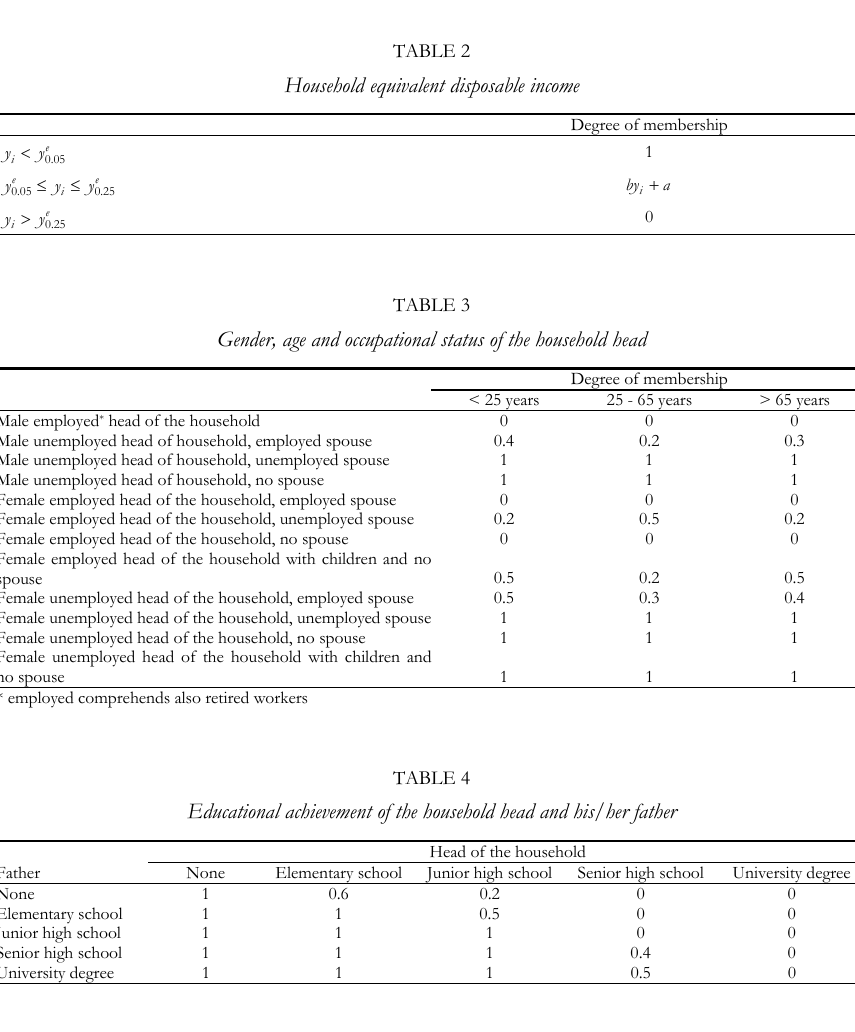
Household equivalent disposable income